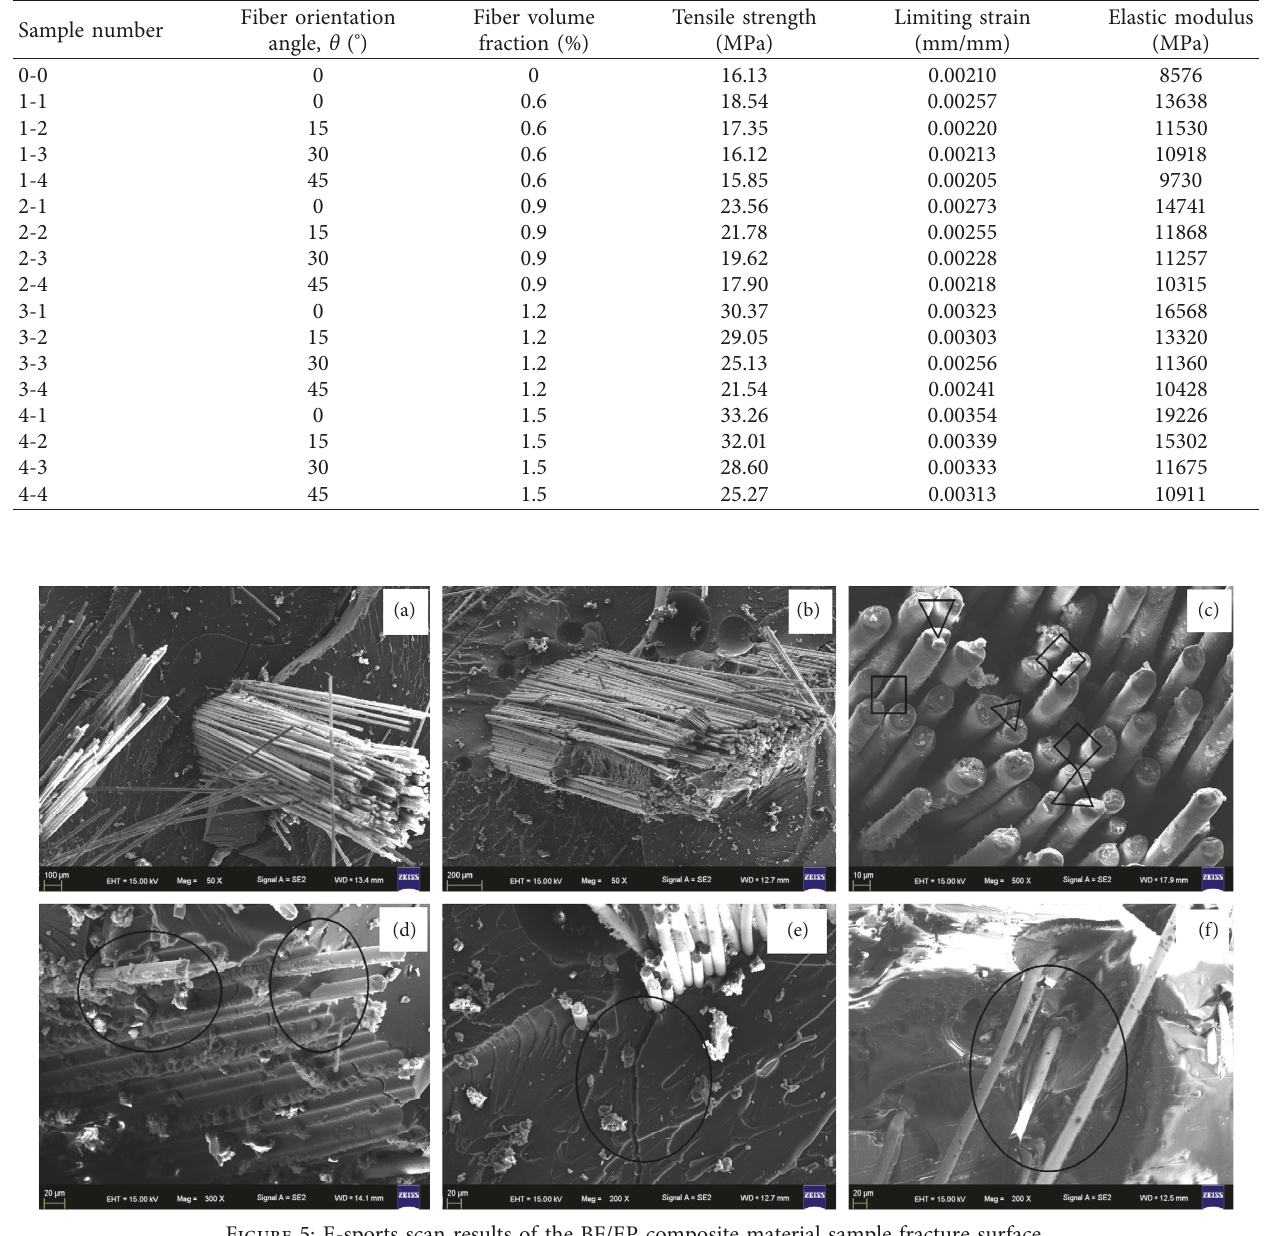
Table 2: Tensile property parameters of BF/EP composite